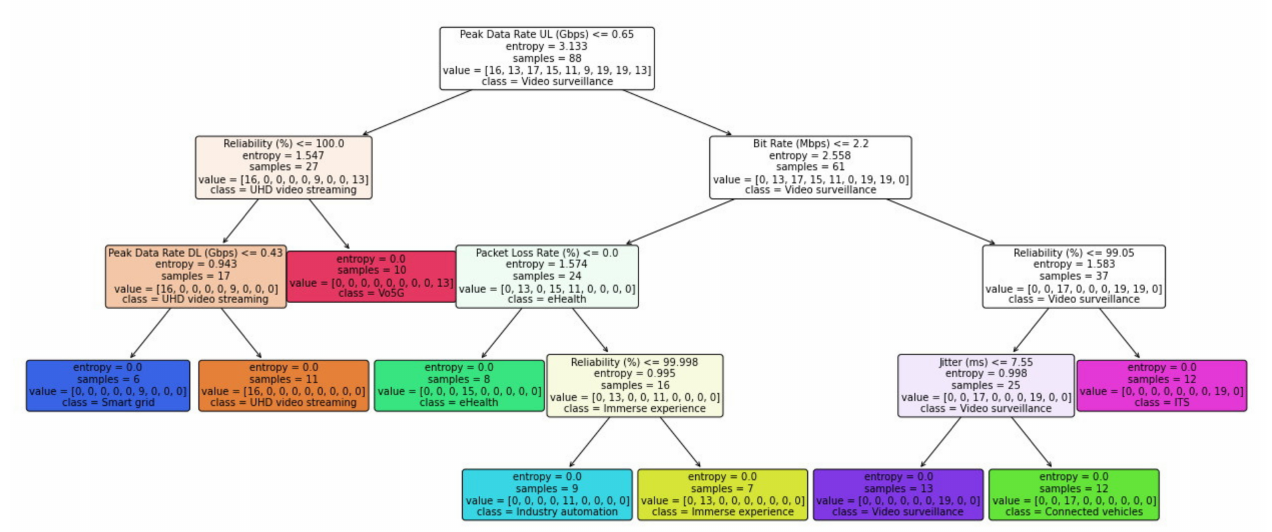
Figure 4. Scheme of one Decision Tree of the Random Forest for the first simulation